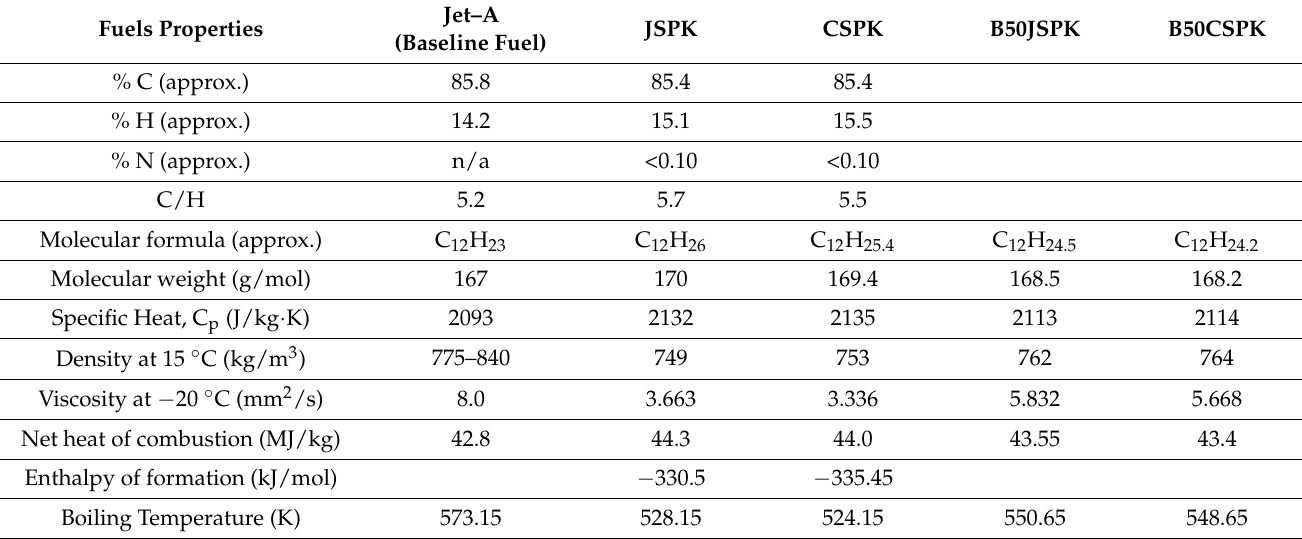
Table 1. Fuel properties data from Mazlan and Savill [22] Kinder and Rahmes